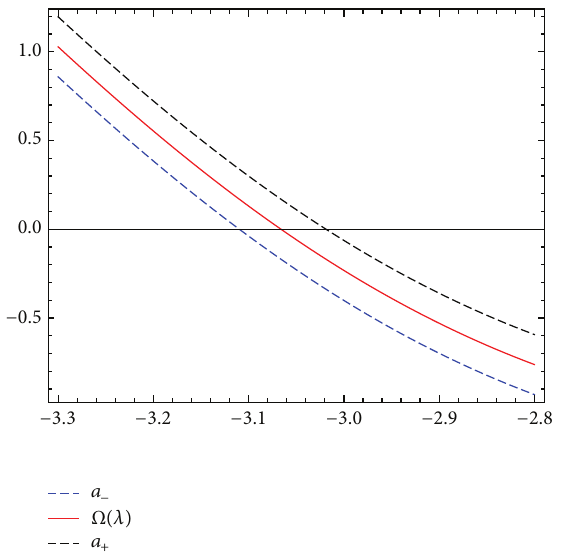
Figure 7: The enclosure interval dominating 𝜆 −1 for ℎ = 0.2 , 𝑁 = 25 , and 𝜀 = 10 −2 .